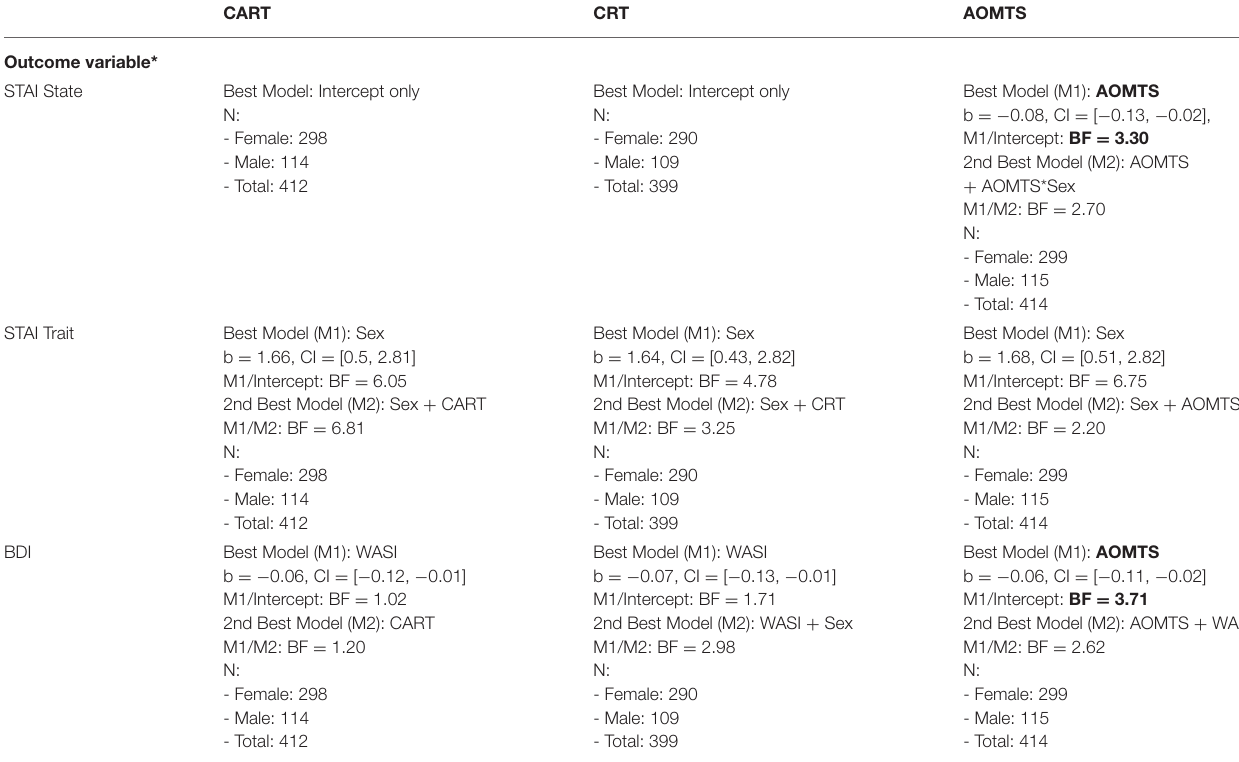
TABLE 4 | Cognitive reflection as a predictor of symptoms. CART CRT AOMTS Outcome variable* STAI State